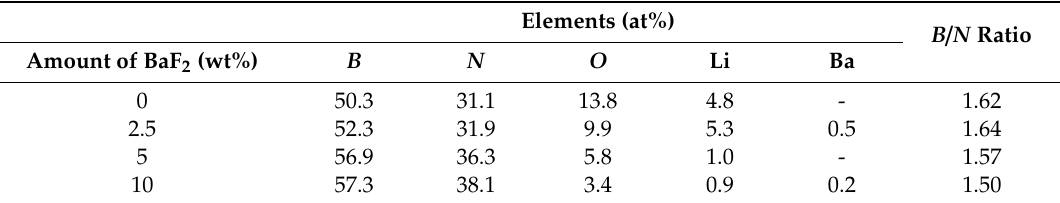
Table 2. Atomic compositions of bulk samples of h BN nanosheets.